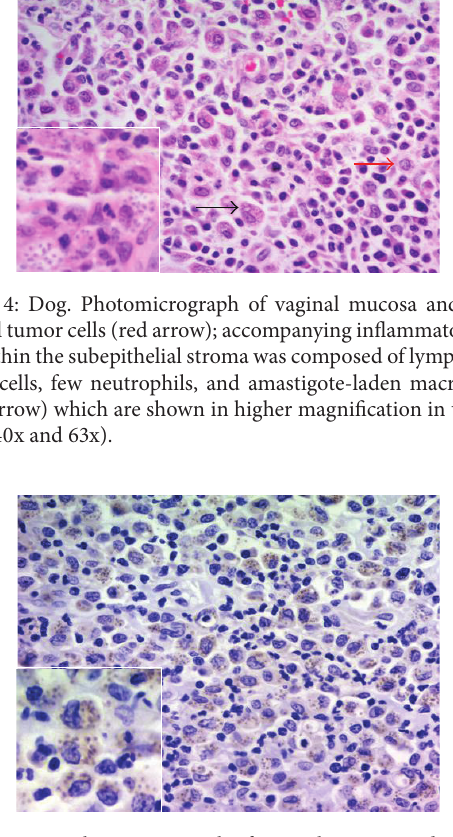
Figure 5: Dog. Photomicrograph of vaginal mucosa and immuno- histochemistry staining highlighting Leishmania sp. amastigotes (DAB hematoxylin-counterstained, 40x and